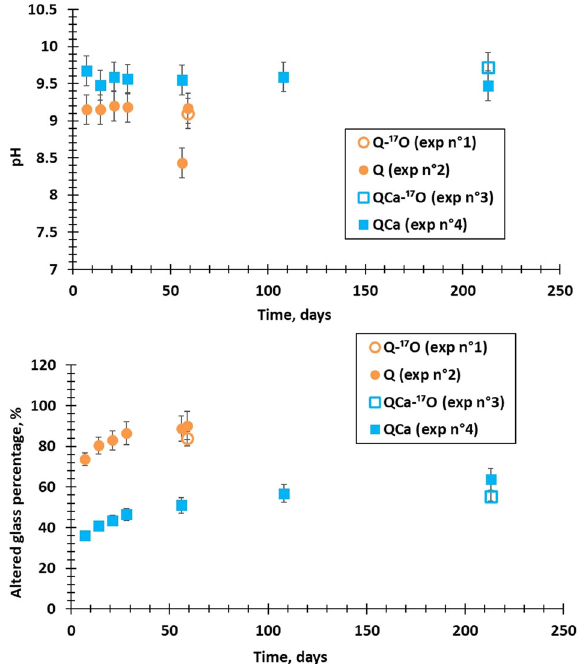
Table 1: (top) Evolution of pH with time ( fi xed error of ±0.2 based on measurement device); (bottom) evolution of percent of altered glass with time (error calculated from the propagation of the error values associated with the boron concentration measured using ICP-OES). Published in partnership with CSCP and USTB npj Materials Degradation (2022)